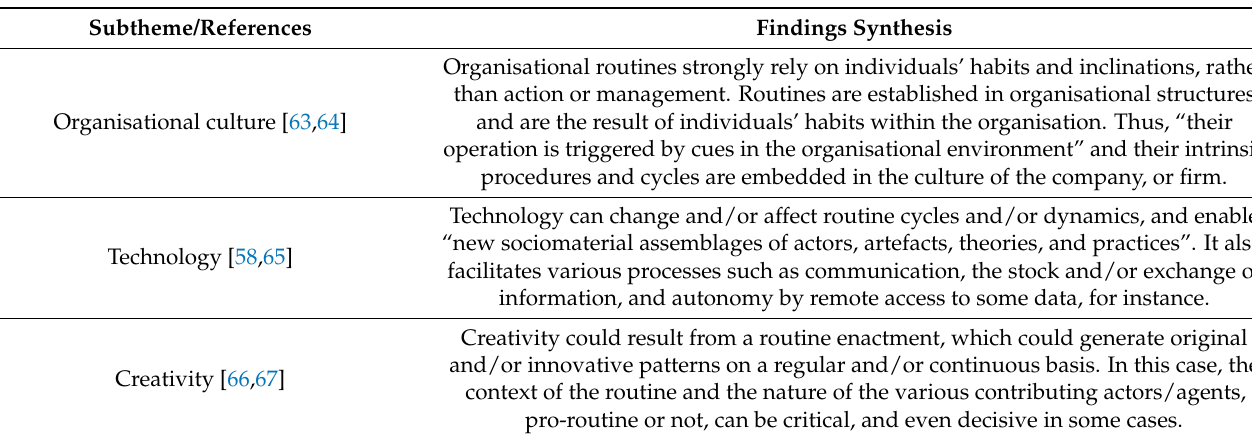
Table 1. Routine and mobile devices, or creativity on the move.